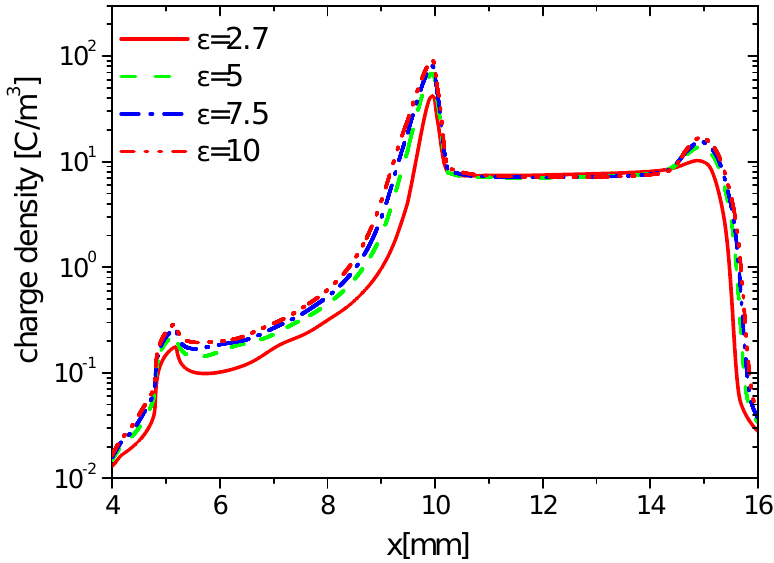
Figure 15. Effect of ε on the distributions of the wall charge density at 35 ns in the fall